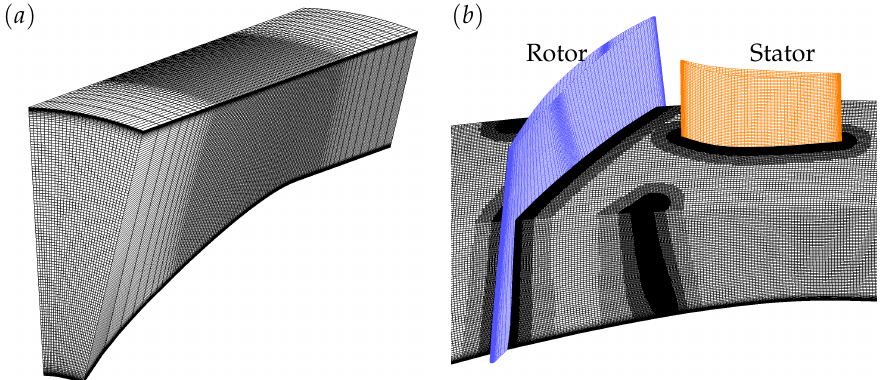
Figure 4. Grid used in the simulations of rotor/stator interaction: ( a ) the background (first-level) grid for the flow channel, and ( b ) part of the multi-level grid with AMR to the blade